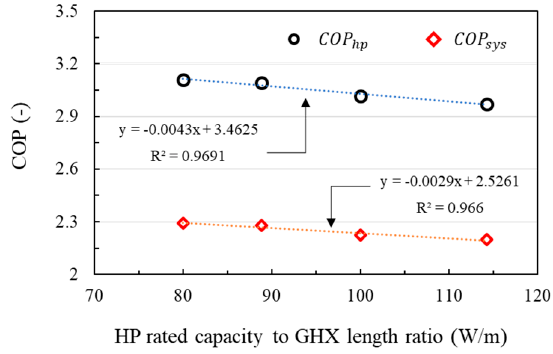
Figure 17. Heat pump COP change according to the GHEX length.